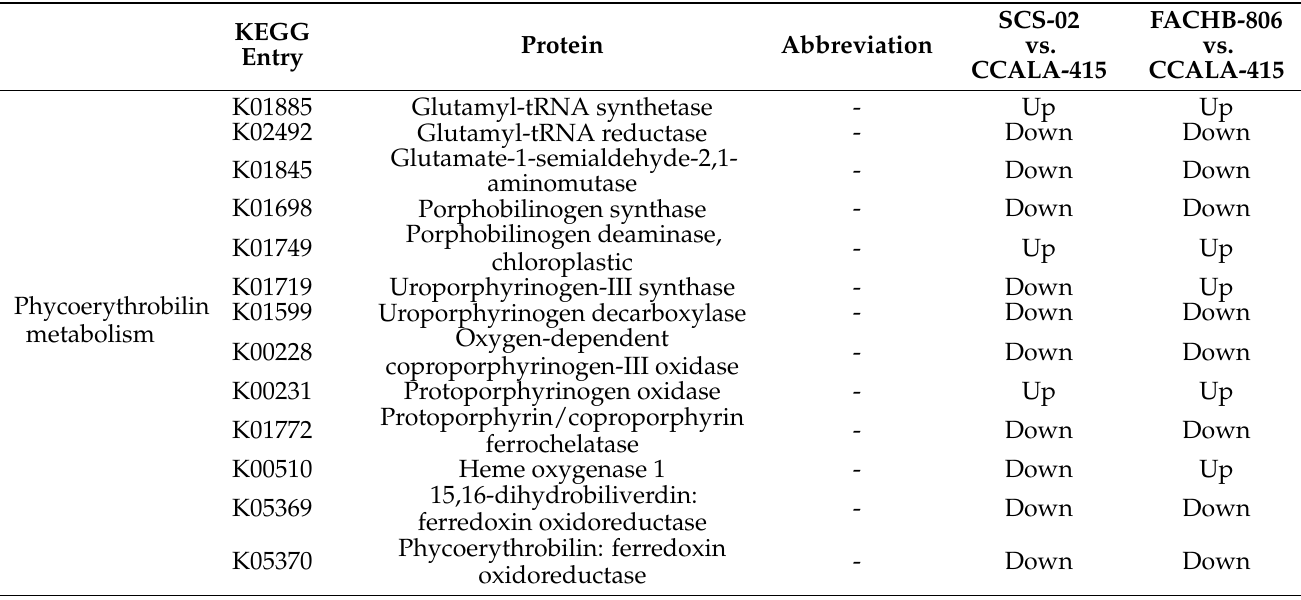
Table 4. The differentially expressed genes in the phycobiliproteins metabolism